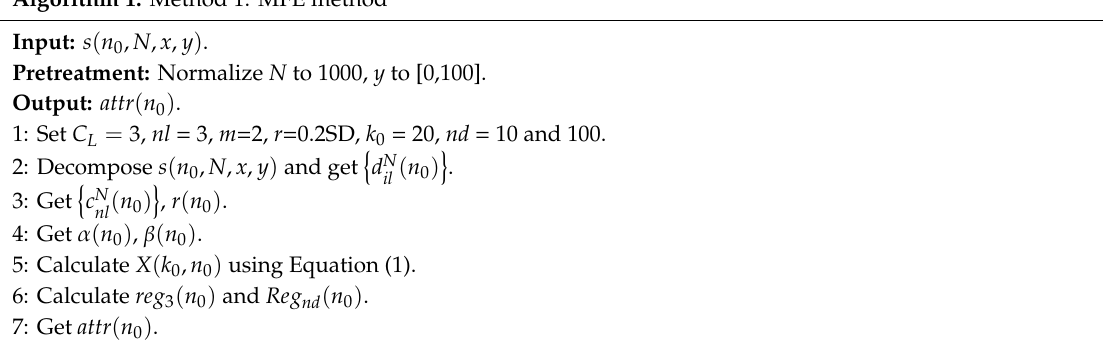
Table 1. Method 1: MFE method